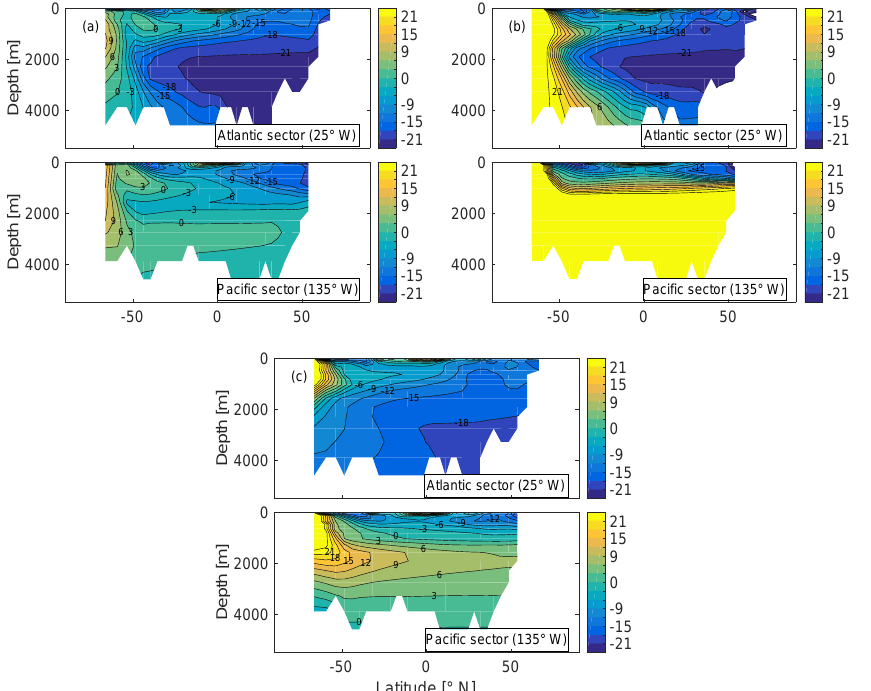
Figure 9. Example sections of C dis = DIC pre − C sat (Appendix B3). The panels show C dis (molkg − 1 ) for (a) WS × 2, with doubled wind stress, (b) AD / 2, with halved atmospheric heat diffusivity and (c) the control equilibrium PIES278. The upper panel of each subfigure shows a section through the Atlantic at 25 ◦ W and the lower panel shows a section through the Pacific at 135 ◦ W. Both sections also cover latitudes that are in the Southern Ocean (south of − 30 ◦